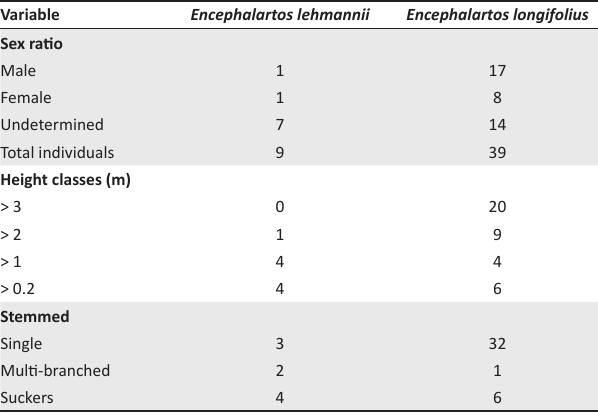
TABLE 1: Summary of cycad individuals.